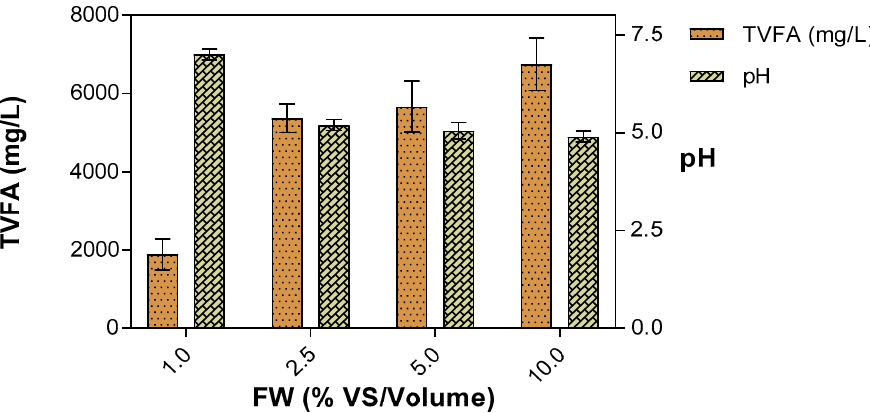
Figure 2. The Total Volatile Fatty Acid (TVFA) concentration and pH at the end of batch tests (the data represented are the average values of the triplicate bottles. The error bars represent the standard deviation).